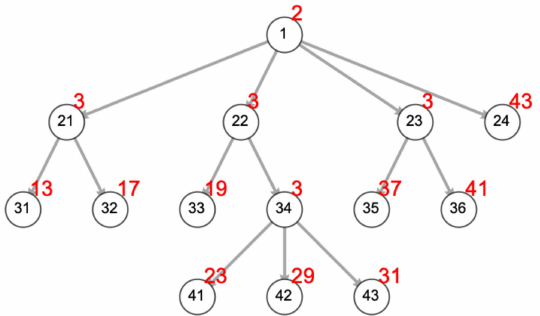
Figure 2. The same BT with prime numbers (red) representing vertex algorithms and omitting